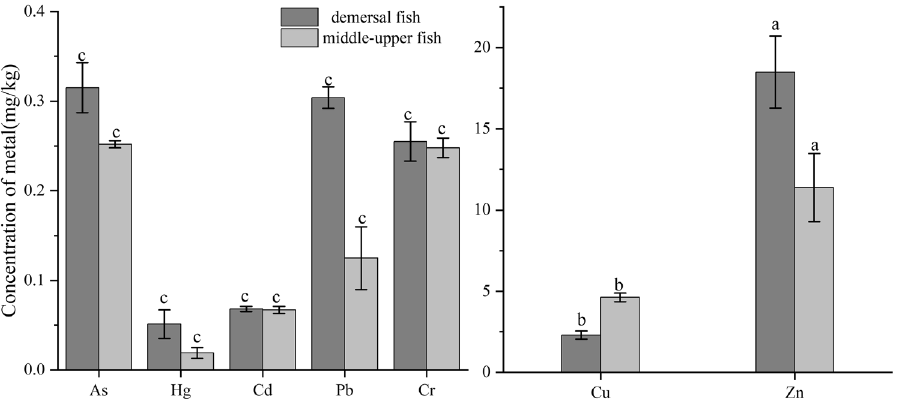
Figure 3. Distribution of heavy metals in different habitats. Different letters are significantly different (P <